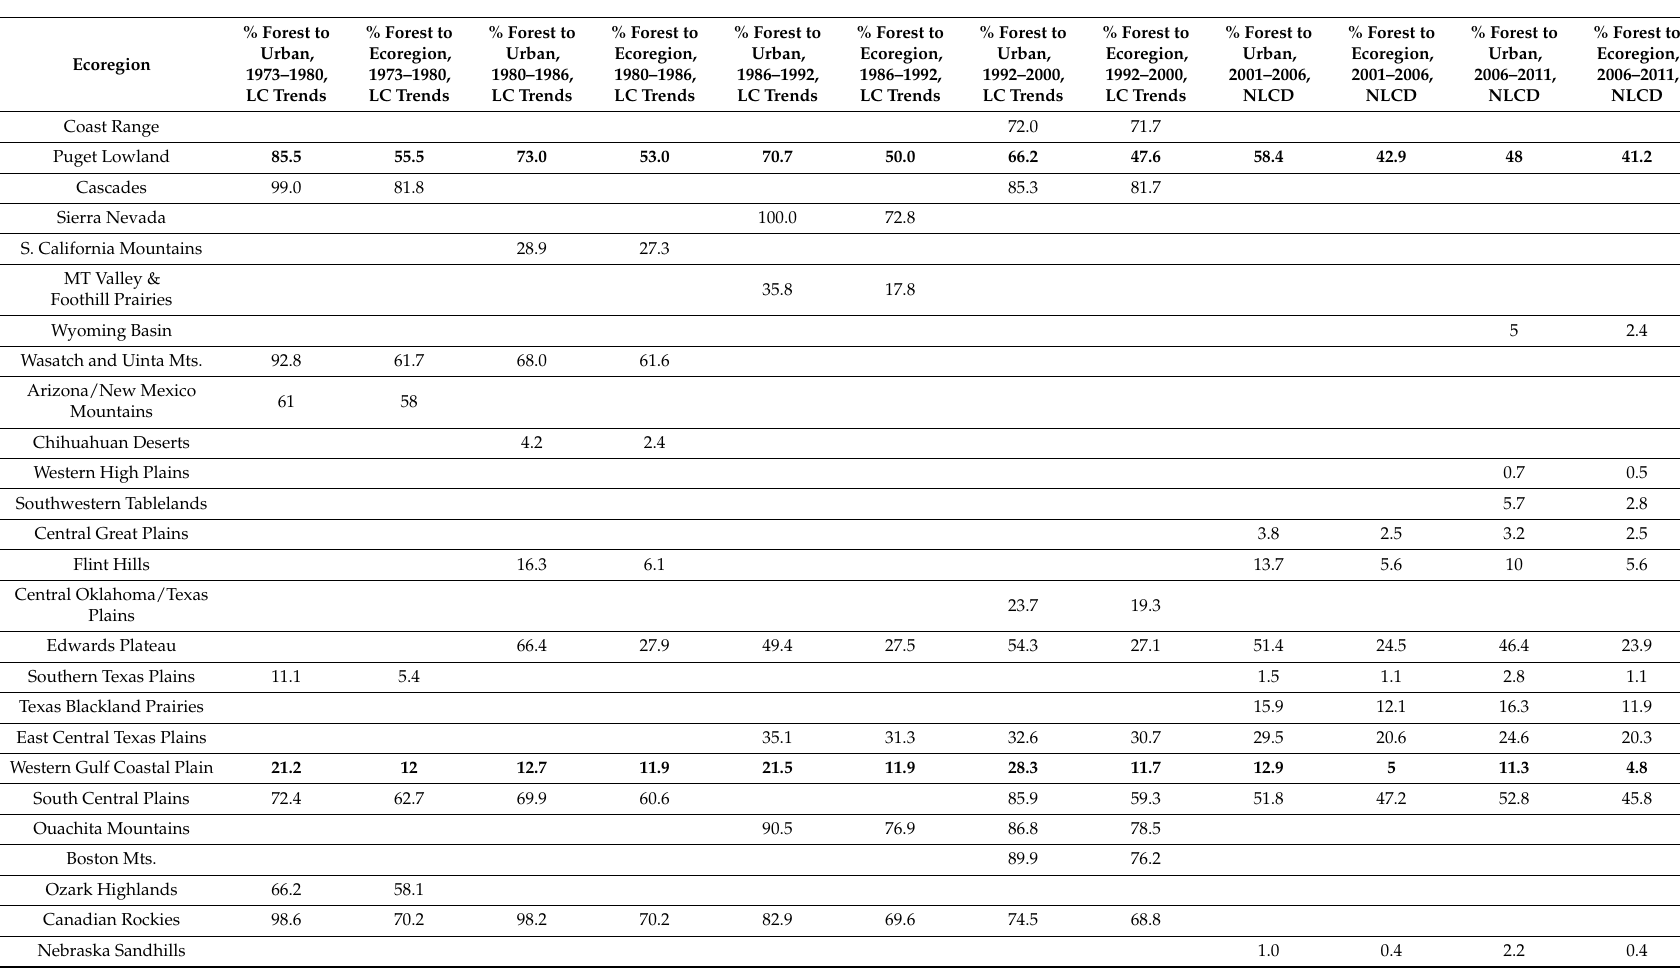
Table 2. Ecoregions exceeding their proportion of forest in forest to developed land cover change in any and all time intervals (all time intervals in bold). Ecoregions where the proportion of forest to developed exceeded the proportion of forest found within the